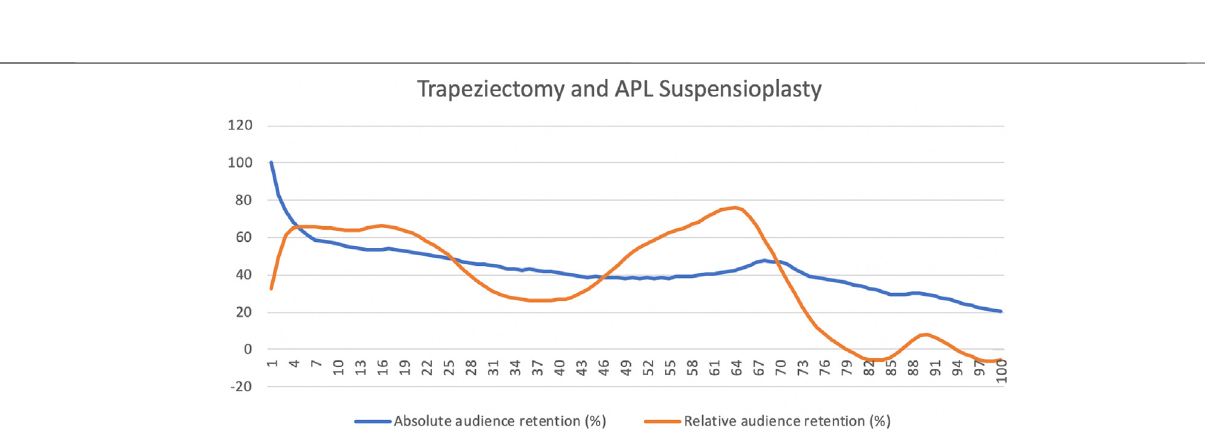
Frontiers in Applied Mathematics and Statistics |